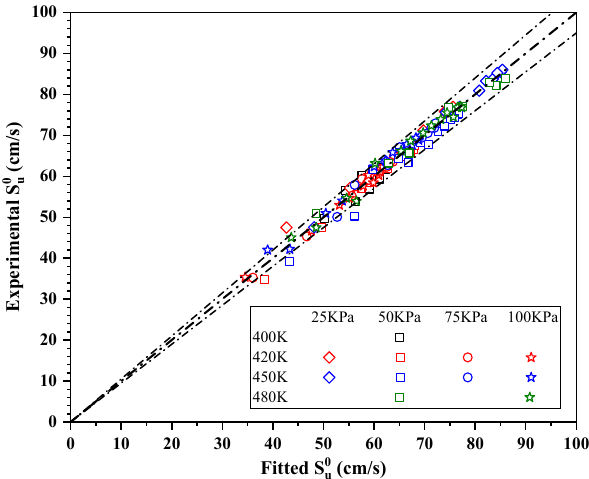
Figure 9. Comparison of the predicted and experimental 𝑆 (cid:3048)(cid:2868) values.